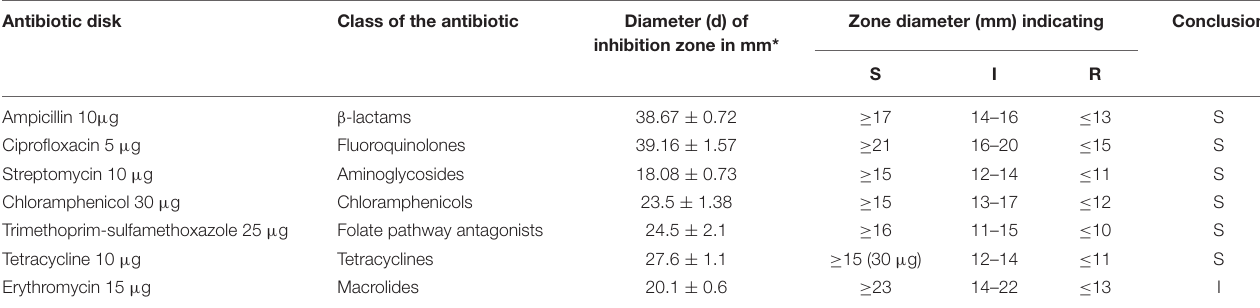
TABLE 1 | Antibiotic susceptibility of R. badensis subsp. acadiensis to different antibiotics using the agar disk diffusion method. Antibiotic